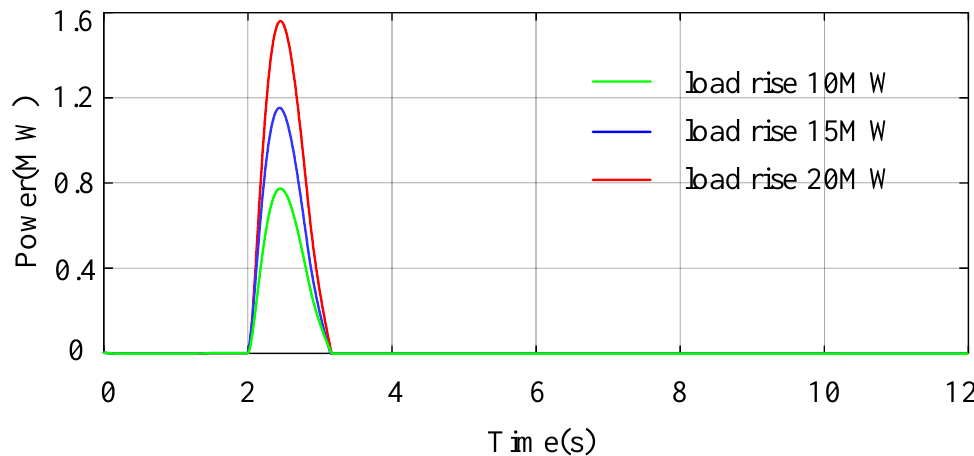
Figure 25. Operation curve of SCESS at high wind speed.